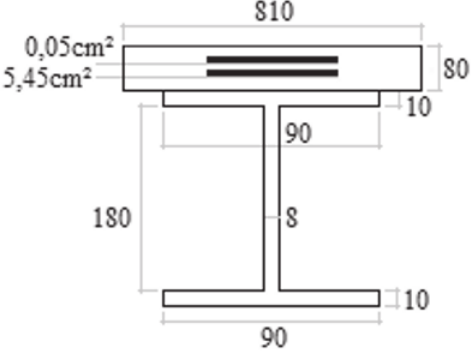
Section defined by the user and initial section defined by the algorithm (dimensions in